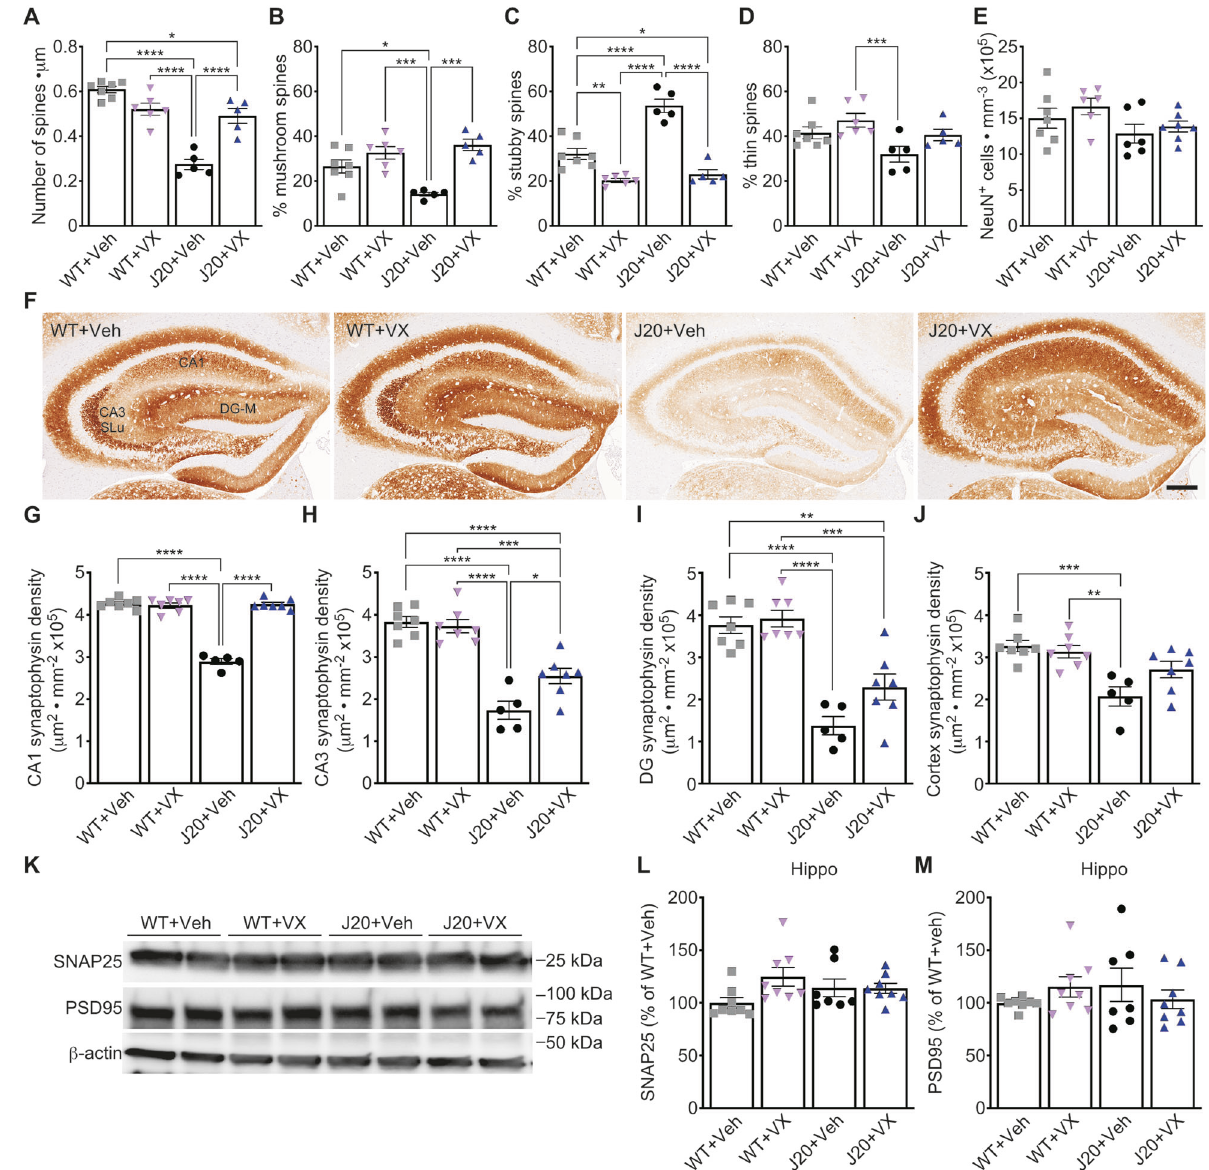
Fig. 2 VX-765 normalizes dendritic spine density and synaptophysin levels in aged J20 hippocampal CA1. A Golgi-Cox dendritic spine density of n = 7 WT + Veh, 6 WT + VX, 5 J20 + Veh, and 5 J20 + VX mice [ F genotype = 56.49, p < 0.0001; F treatment = 7.11, p = 0.02; = 39.43, p < 0.0001] and percentage number of ( B ) mushroom [ F = 28.85, p < 0.0001; F = 9.25, p < 0.007], C stubby F interaction treatment interaction [ F genotype = 29.22, p < 0.0001; F treatment = 90.30, p < 0.0001; F interaction = 17.73, p = 0.0004], and ( D ) thin [F genotype = 7.30, p = 0.01; = 5.65, p = 0.03] spine subtypes. E NeuN + cell density in the hippocampal CA1 PCL [ F = 4.40, p = 0.05]. F Representative F treatment genotype synaptophysin immunostaining in the hippocampus. Separate density quanti fi cations were made in the hippocampal CA1, stratum lucidum of the CA3 (CA3 SLu), and the molecular layer of the dentate gyrus (DG-M). Scale bar = 250 μ m. G – J Synaptophysin staining density of n = 7 WT + Veh, 7 WT + VX, 5 J20 + Veh, and 7 J20 + VX mice in the ( G ) CA1 [ F genotype = 157.3, p < 0.0001; F treatment = 150.7, p < 0.0001; = 173.6, p < 0.0001], ( H ) CA3 [ F = 92.38, p < 0.0001; F = 4.31, p = 0.05; F = 7.22, p = 0.01], ( I ) DG [F F interaction genotype treatment interaction = 68.63, p < 0.0001; F = 4.85, p = 0.04], and ( J ) cortex [ F = 21.67, p = 0.0001; F = 4.89, p = 0.04]. genotype treatment genotype interaction K Representative western blot images and quanti fi cation of hippocampal ( L ) SNAP25 and ( M ) PSD95 of n = 8 WT + Veh, 8 WT + VX, 7 J20 + Veh, and 8 J20 + VX mice. Two-way ANOVA, Bonferroni ’ s post-hoc for all panels. Bars represent mean ± SEM; symbols denote performances of individual mice. * p < 0.05, ** p < 0.01, *** p < 0.001, **** p < synaptophysin density decreased in J20 compared to WT and was in the cortical retrosplenial (RS) and adjacent motor and partially restored with VX-765 (Fig. 2J). No changes in synaptophysin somatosensory areas (Fig. S3B) in 15-month-old J20. Synaptophy- density were observed in the CA1, CA3, DG or cortex of VX-765- sin density decreased in the hippocampal CA1, CA3 stratum treated WT (Fig. 2G – J). The pre- and post-synaptic proteins, SNAP25 lucidum (SLu), and DG-M in vehicle-treated J20 relative to WT and PSD95, respectively, assessed with western blot (Fig. 2K), did not (Fig. 2G – I). Synaptophysin density was normalized in the CA1 change between WT and J20 or after VX-765 (Fig. 2L, M). These (Fig. 2G), partially restored in the CA3-SLu (Fig. 2H), and unaltered results indicate that VX-765 normalization of hippocampal in the DG-M (Fig. 2I) of VX-765-treated J20. In the cortex,